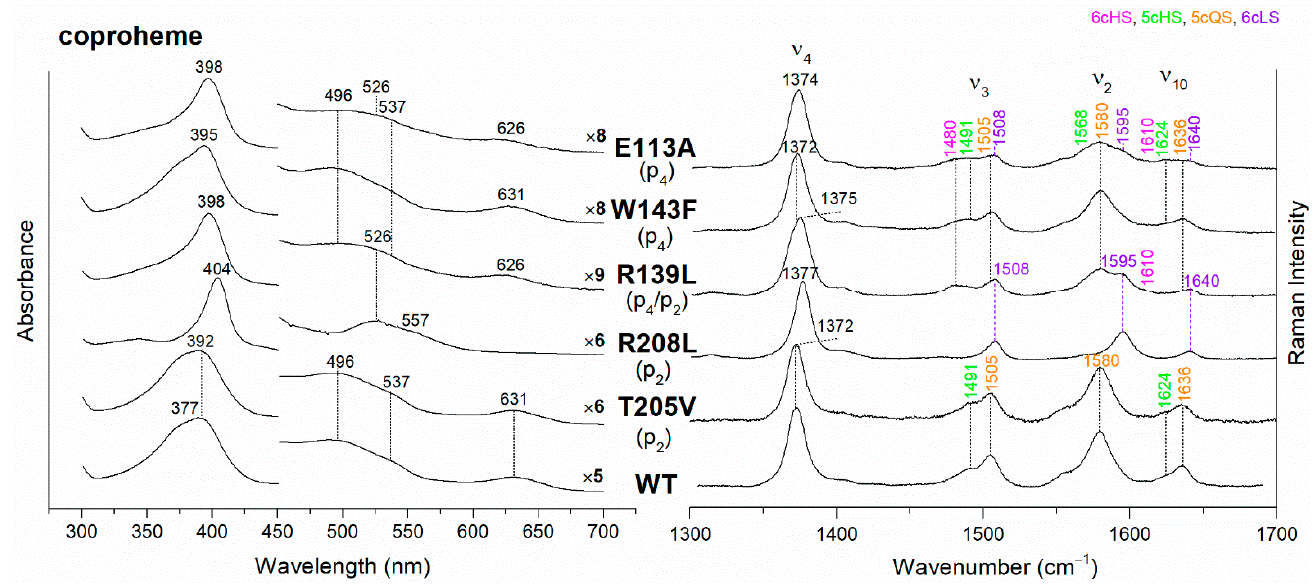
Figure 2. ( Left ) UV-vis electronic absorption spectra, and ( Right ) RR spectra in the high wavenumber region of coproheme complexes of Cd ChdC WT and variants. In brackets, the propionate, whose corresponding H-bond is removed by mutation, is reported. The RR core-size marker band wavenumbers are reported in pink, green, orange and violet for the 6cHS, 5cHS, 5cQS and 6cLS species, respectively. In black, at the side of the UV-vis spectra, are indicated the expansion factors applied in the 450–700 nm spectral range for better data visualization.